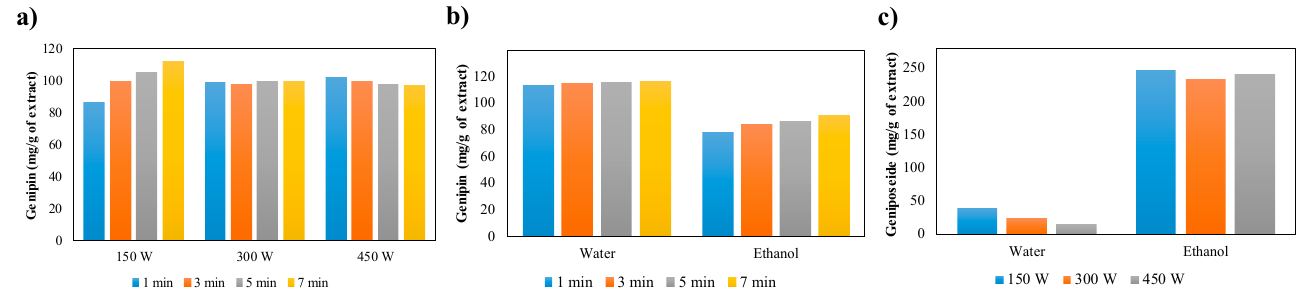
Figure 3. Effect of the process parameters on genipin and geniposide content: ( a ) extraction time and power on genipin content, ( b ) solvent and extraction time on genipin content, and ( c ) solvent and power on geniposide content. Results are expressed on a dry basis. Standard deviation by ANOVA for genipin = 0.6 and for geniposide = 5.5.